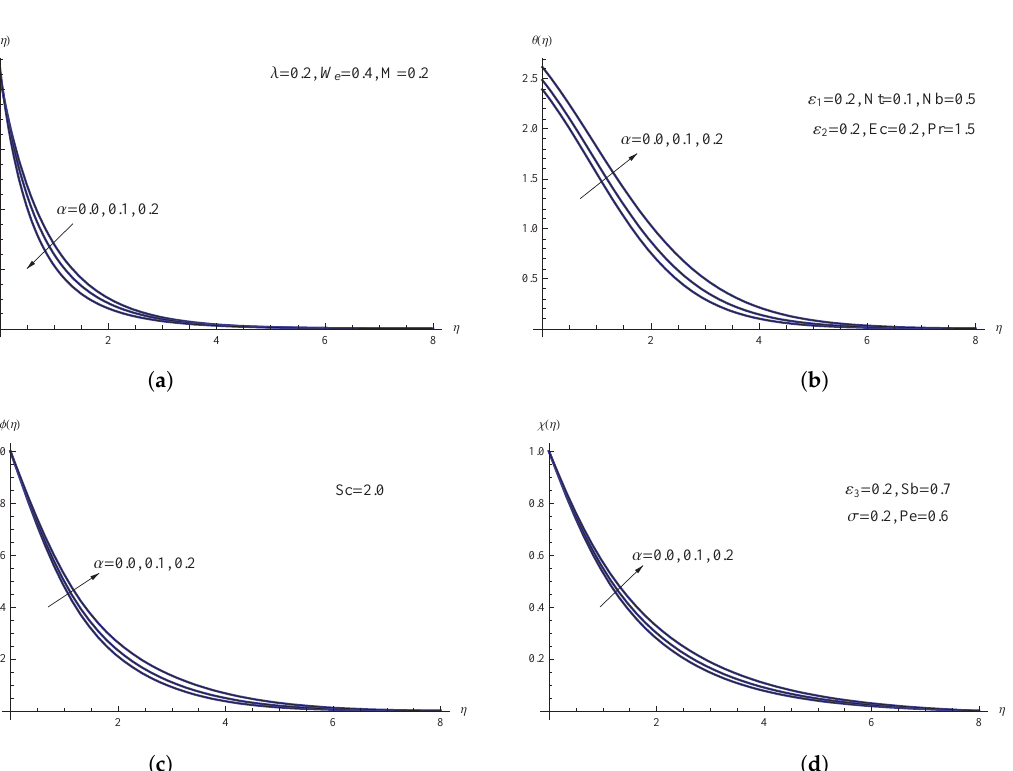
Figure 3. ( a ) f (cid:48) ( η ) for various λ . ( b ) θ ( η ) for various λ . ( c ) φ ( η ) for various λ . ( d ) χ ( η ) for various λ .